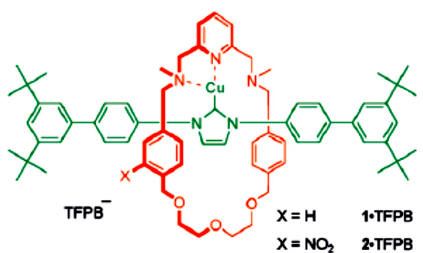
Molecules 2022 , 27 , x FOR PEER REVIEW 35 of 81 Figure 3. Structure of the interlocked NHC-Cu I complexes 1-TFPB and 2-TFPB [40].